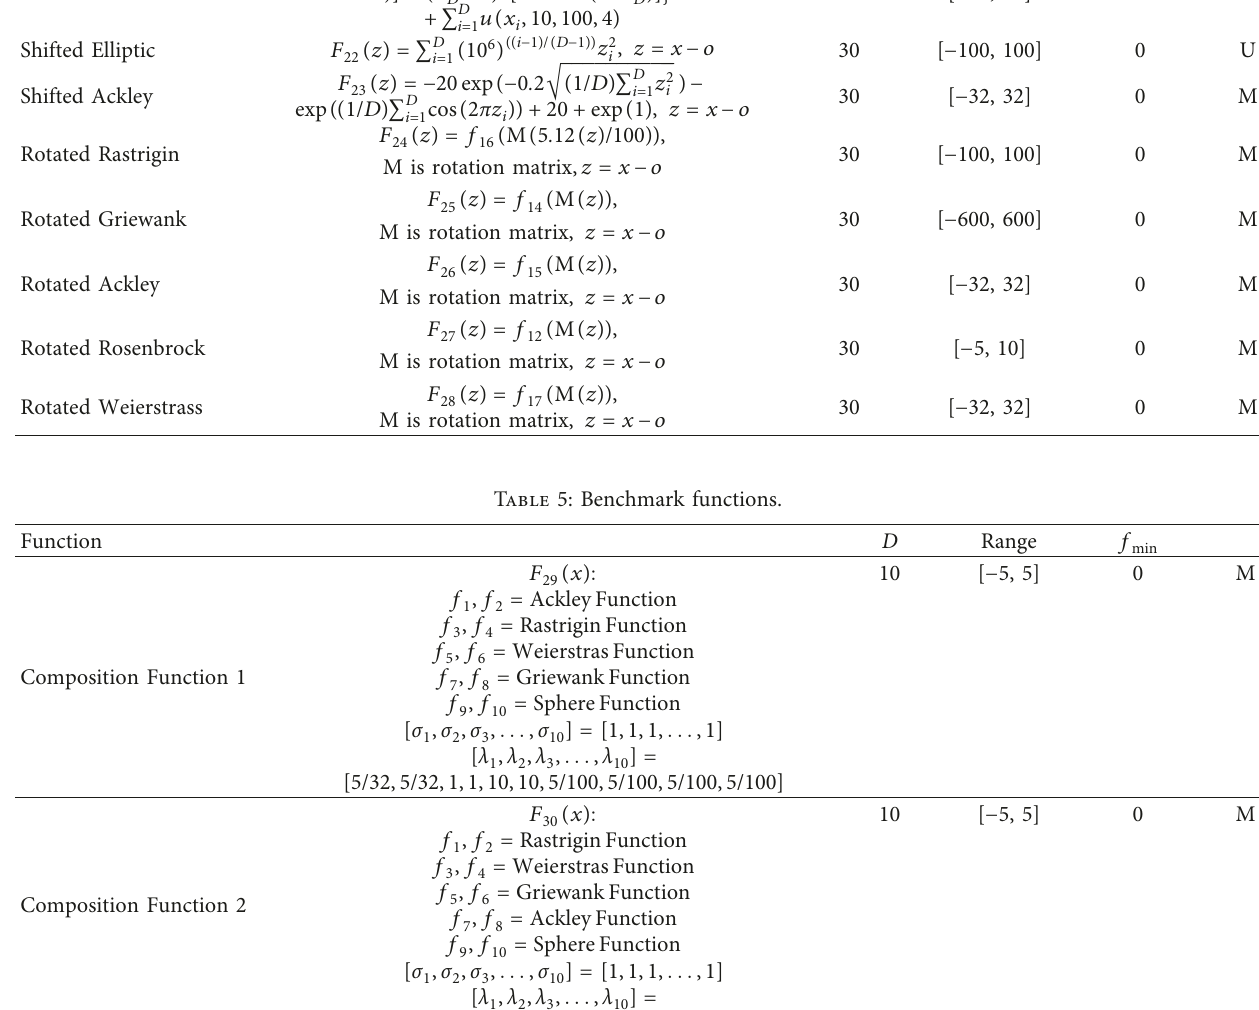
2 and Ce-doped compositions from EDX analysis.